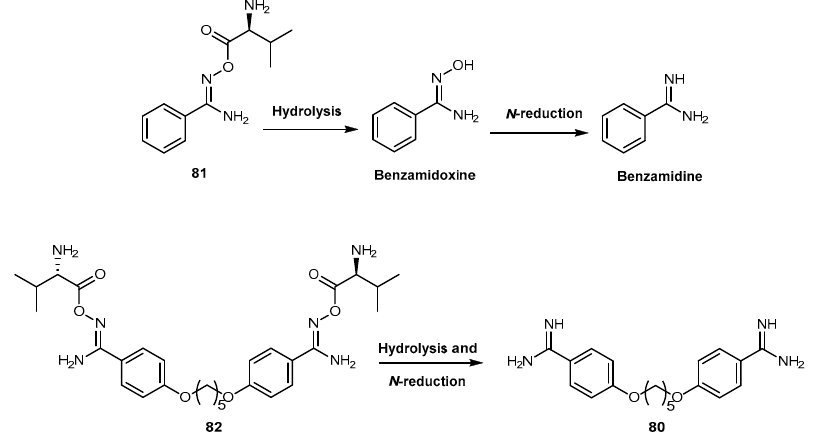
Figure 34. Metabolic activation of N -valoxybenzamidine and N , N ′ -bis(valoxy)pentamidine (reproduced from